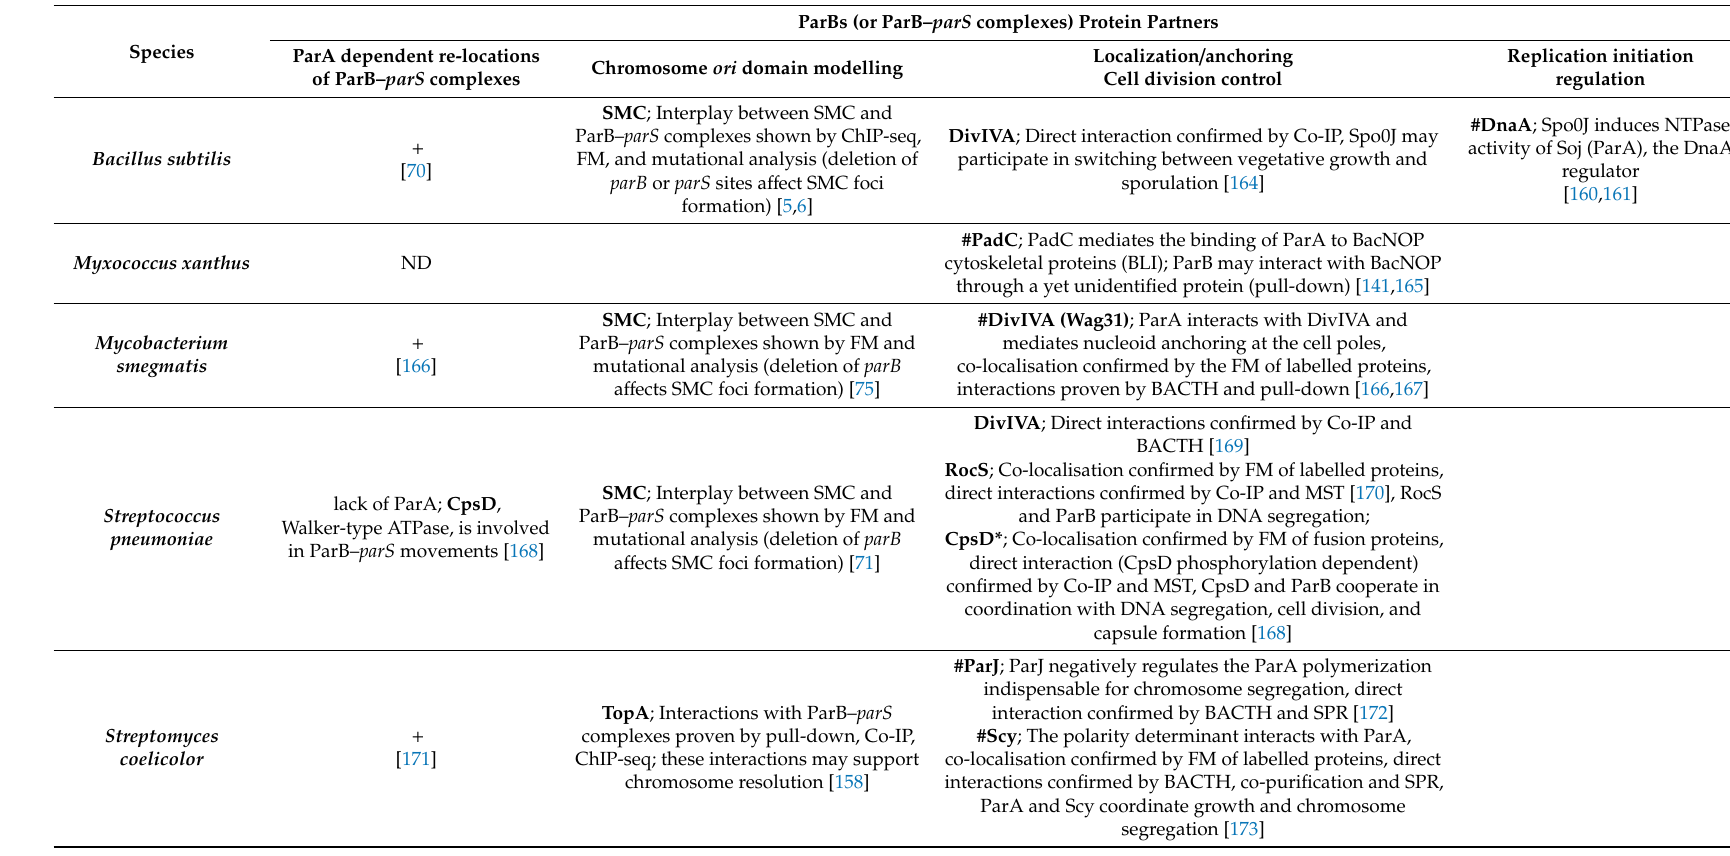
Table 2. Interactions of ParBs (or ParB– parS complexes) with protein partners and the methods used for their analysis.